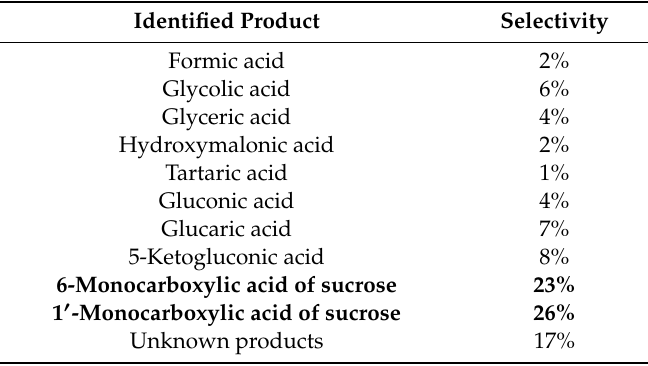
Table 1. Chromatographic analysis of long term electrolysis of sucrose on gold